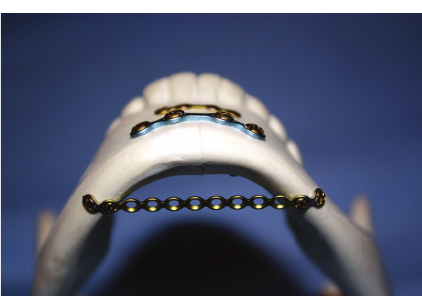
Figure 3: Two parallel plates plus spanning plate (SP1).